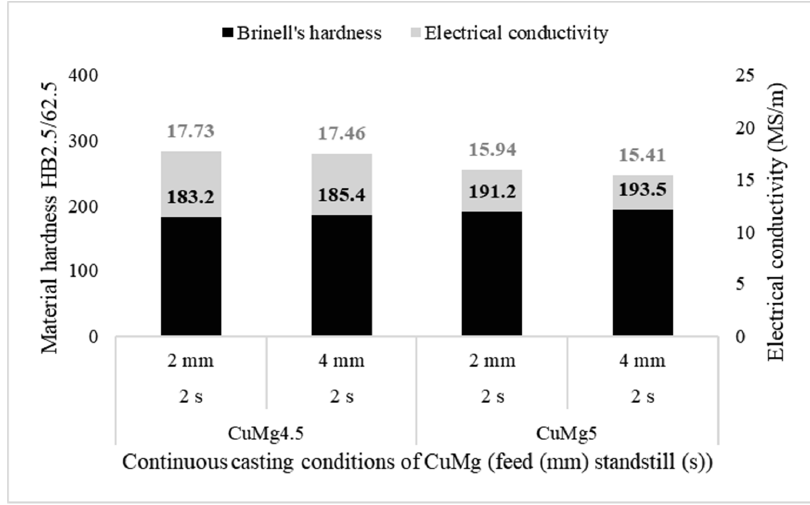
Figure 10. Mean values of electrical conductivity (grey columns) and Brinell’s hardness (black columns) of each of the tested samples after compression test (50% applied deformation) .